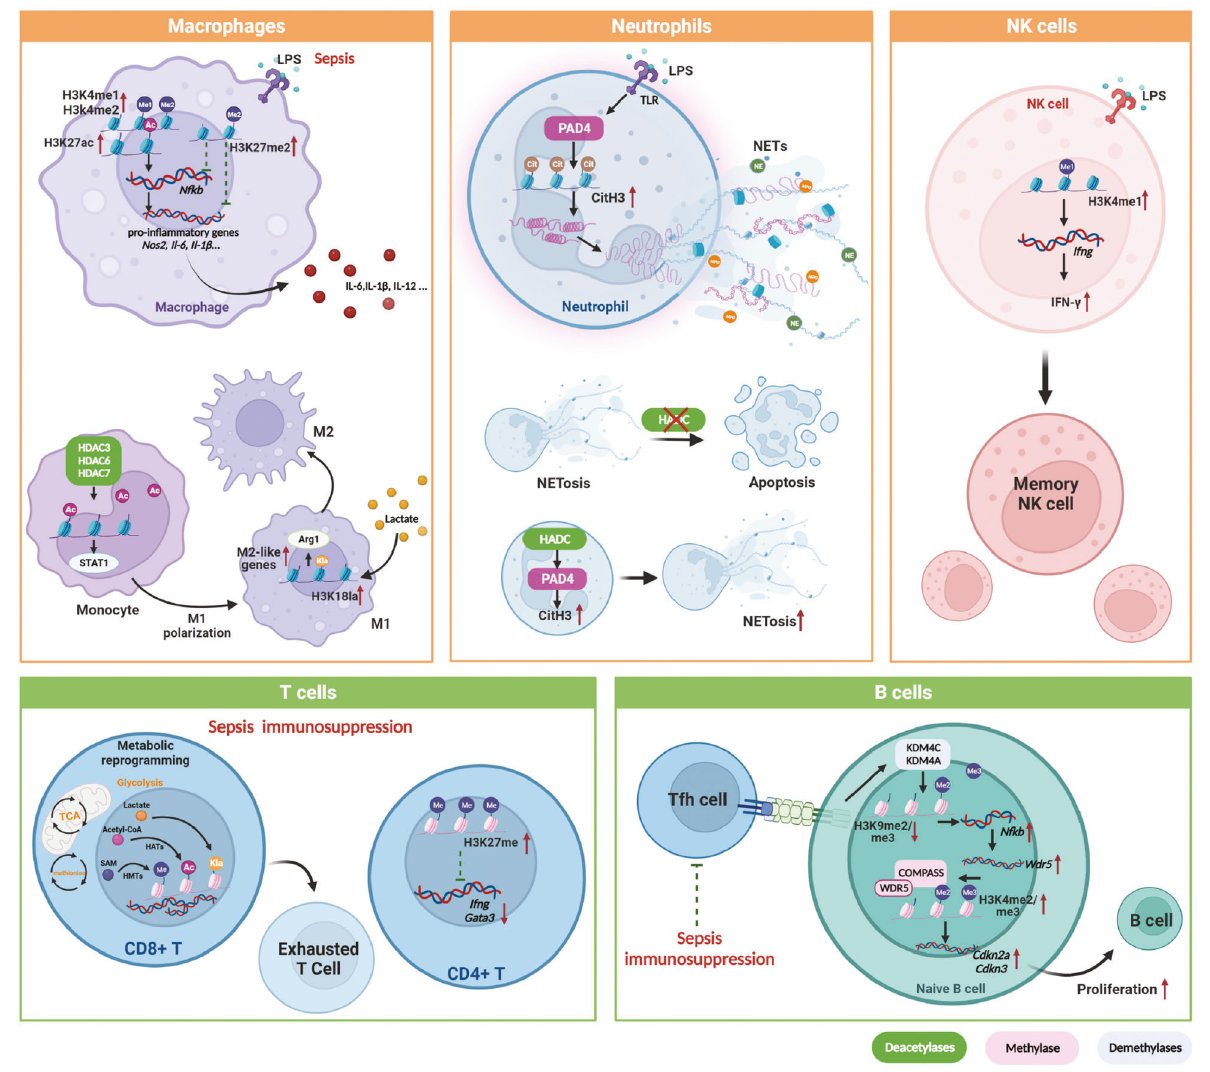
Fig. 3 Histone modi fi cations regulate immunity remodeling in sepsis. In sepsis or endotoxemia models constructed by LPS, histone modi fi cations are involved in the functional regulation of innate immunity and adaptive immunity. Speci fi cally, histone modi fi cations regulate polarization and in fl ammatory factor secretion in macrophage and NETs production and shift of death paradigm in neutrophils, as well as the generation of memory NK cells. In adaptive immunity, histone modi fi cations act as players in forming exhausted T cells. Simultaneously, it is associated with the process of Tfh-induced B cell proliferation. LPS, lipopolysaccharide; IL, interleukin; NETs, neutrophils extracellular traps; T, T lymphocytes; B, B lymphocytes; NK, natural killer cells; Tfh, T follicular helper cell; IFN, interferon; TCR, Toll-like receptor; TCA, tricarboxylic